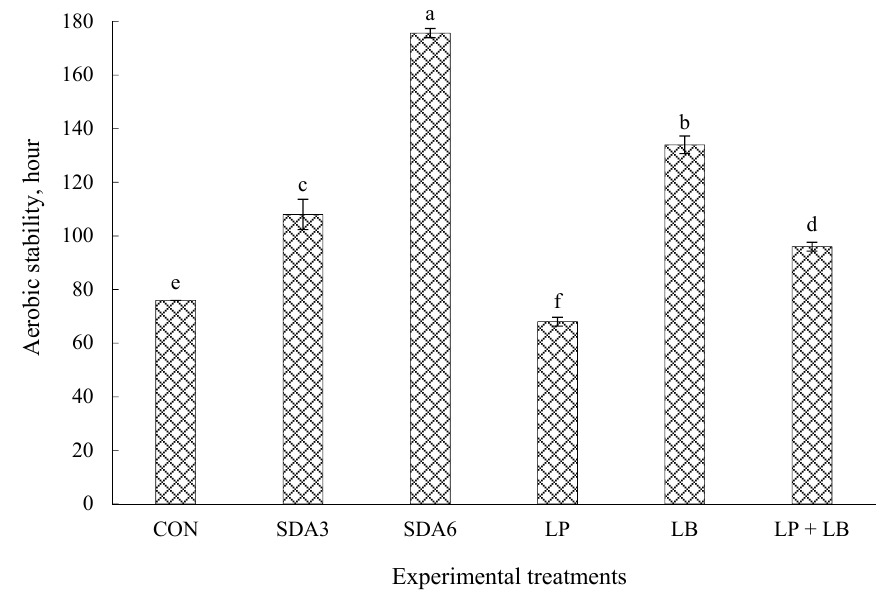
Figure 1. Aerobic stability of early-harvested rye ensiled for 60 d with different additives. Experimental silages were untreated silage (CON); SDA3 = sodium diacetate at 3 g/kg fresh weight; SDA6 = sodium diacetate at 6 g/kg fresh weight; LP = L. plantarum ; LB = L. buchneri ; LP+LB = L. plan- tarum + L. buchneri (equal proportion). Inoculant application rate was 1,000,000 cfu/g fresh weight. a-f Means (±standard deviation) with unlike superscripts differ (based on Duncan’s test; p<0.05).